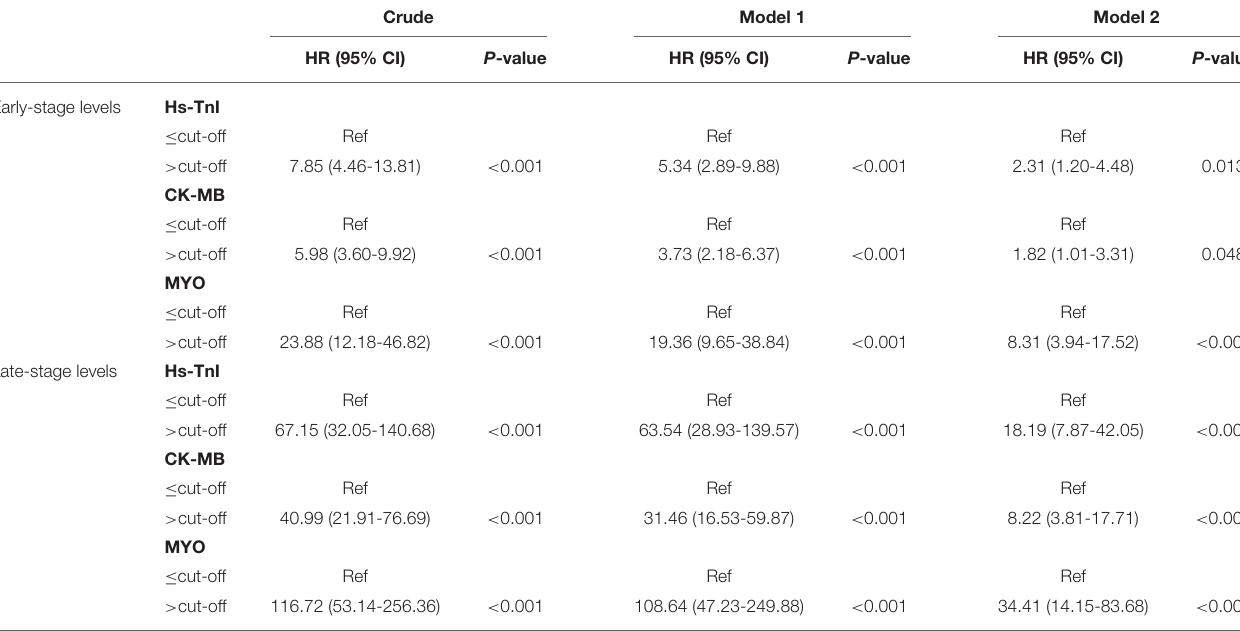
TABLE 4 | Associations of increased myocardial marker levels above cut-offs with in-hospital mortality of